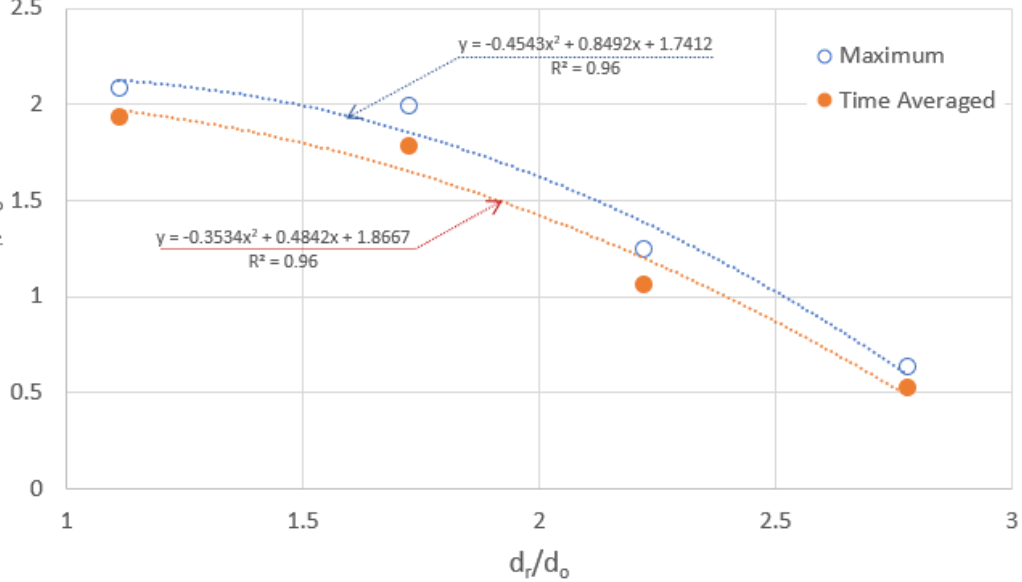
Figure 16. Relations of the max/average tip rotor’s speed ratio with the rotor’s size (4-blade rotors).